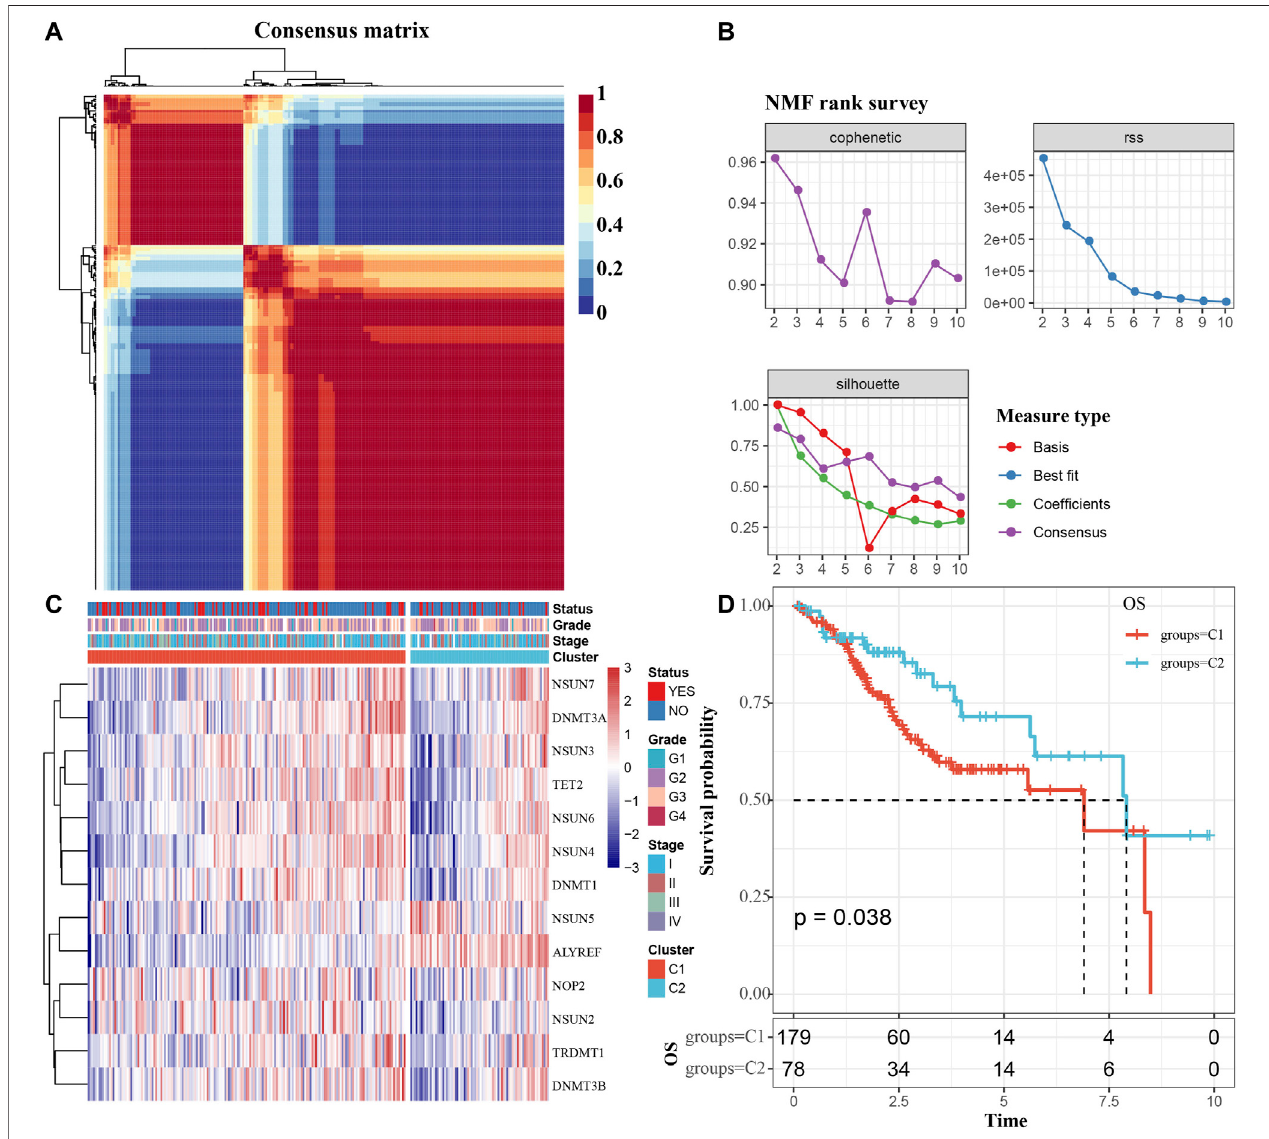
FIGURE 2 | Determination of m5C modi fi cation subtype. (A) Consensus map for NMF clustering. (B) The cophenetic, rss and silhouette distribution when the numberofclusterskwassetas2to10.Thecophenetic correlation isused tore fl ect thestabilityofclusterobtainedfromNMF, weselectkvaluewherethemagnitudeof thecopheneticcorrelationcoef fi cientbeginstofall.The “ rss ” referstoresidualsumofsquares,asmallervaluerepresentstheeffectofmodelclustering.Silhouetteisused tostudythedistancebetweenclustersofclusteringresults,Whenthesilhouettevalueiscloserto1,theclusteringismorereasonable.Accordingtocophenetic,rss and silhouette, the optimal number of clusters was two under comprehensive consideration. (C) m5c methylation-related gene cluster maps. (D) KM survival curves of m5C modi fi cation subtypes. Time: years.